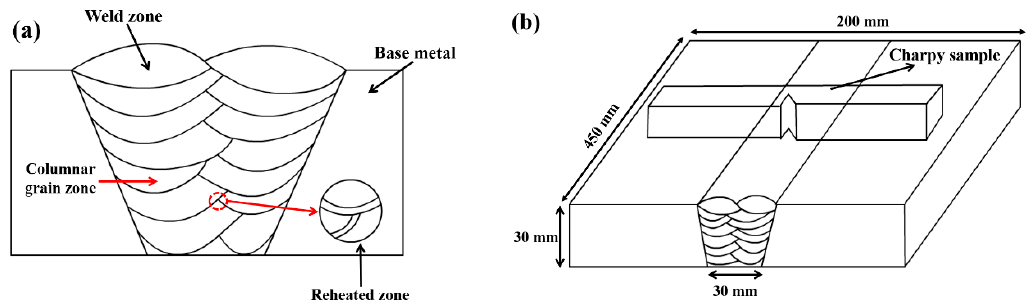
Figure 1. Schematic diagrams of ( a ) multi-layer multi-pass welding welded joint and ( b ) welded joint sampling impact specimen. Table 1. Chemical compositions of the weld zone (wt %).